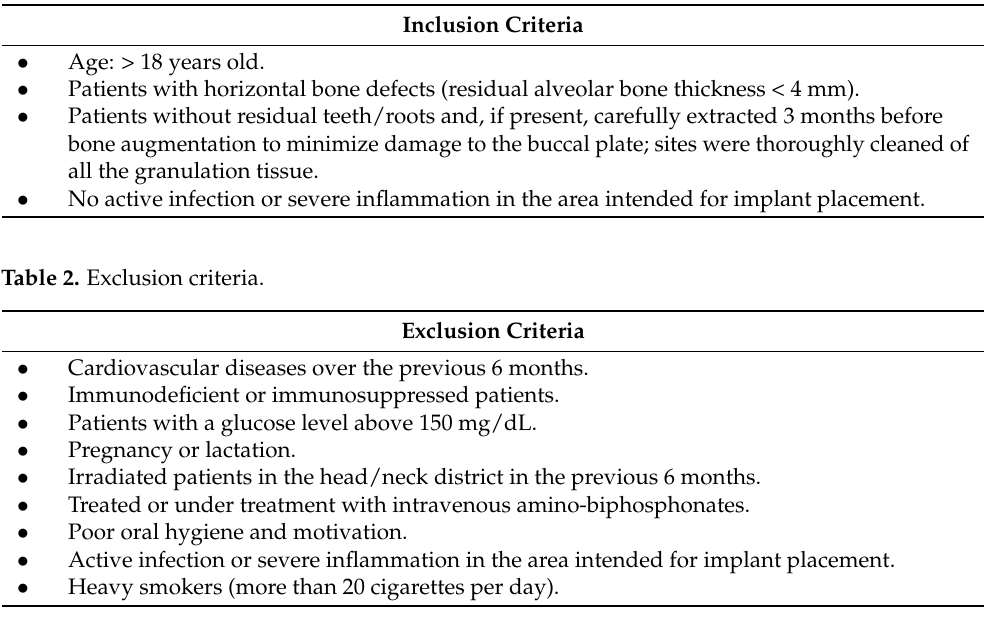
Table 1. Inclusion criteria.